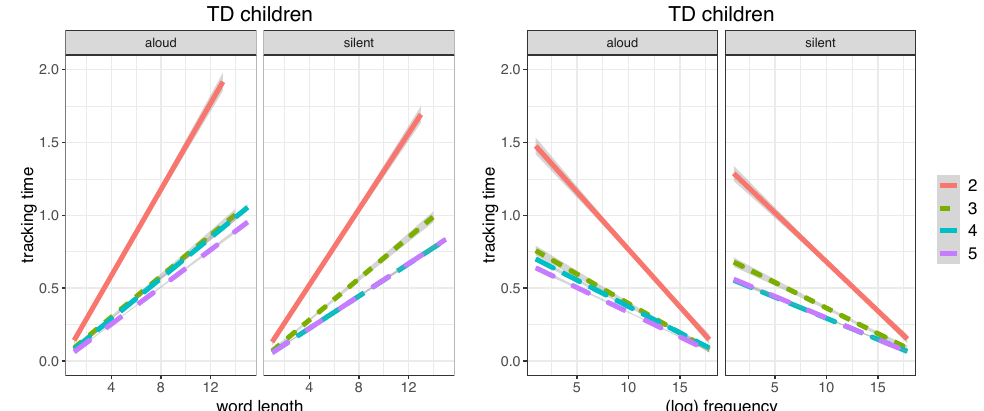
Figure 3. Linear regression plots for word length ( left ) and word frequency ( right ) in TD children for the four grade levels (from 2nd to 5th) in the aloud and silent reading modalities, fitting word tracking time (in seconds) (plot obtained with the ggplot2 package, function lm ; shaded areas indicate 95% confidence